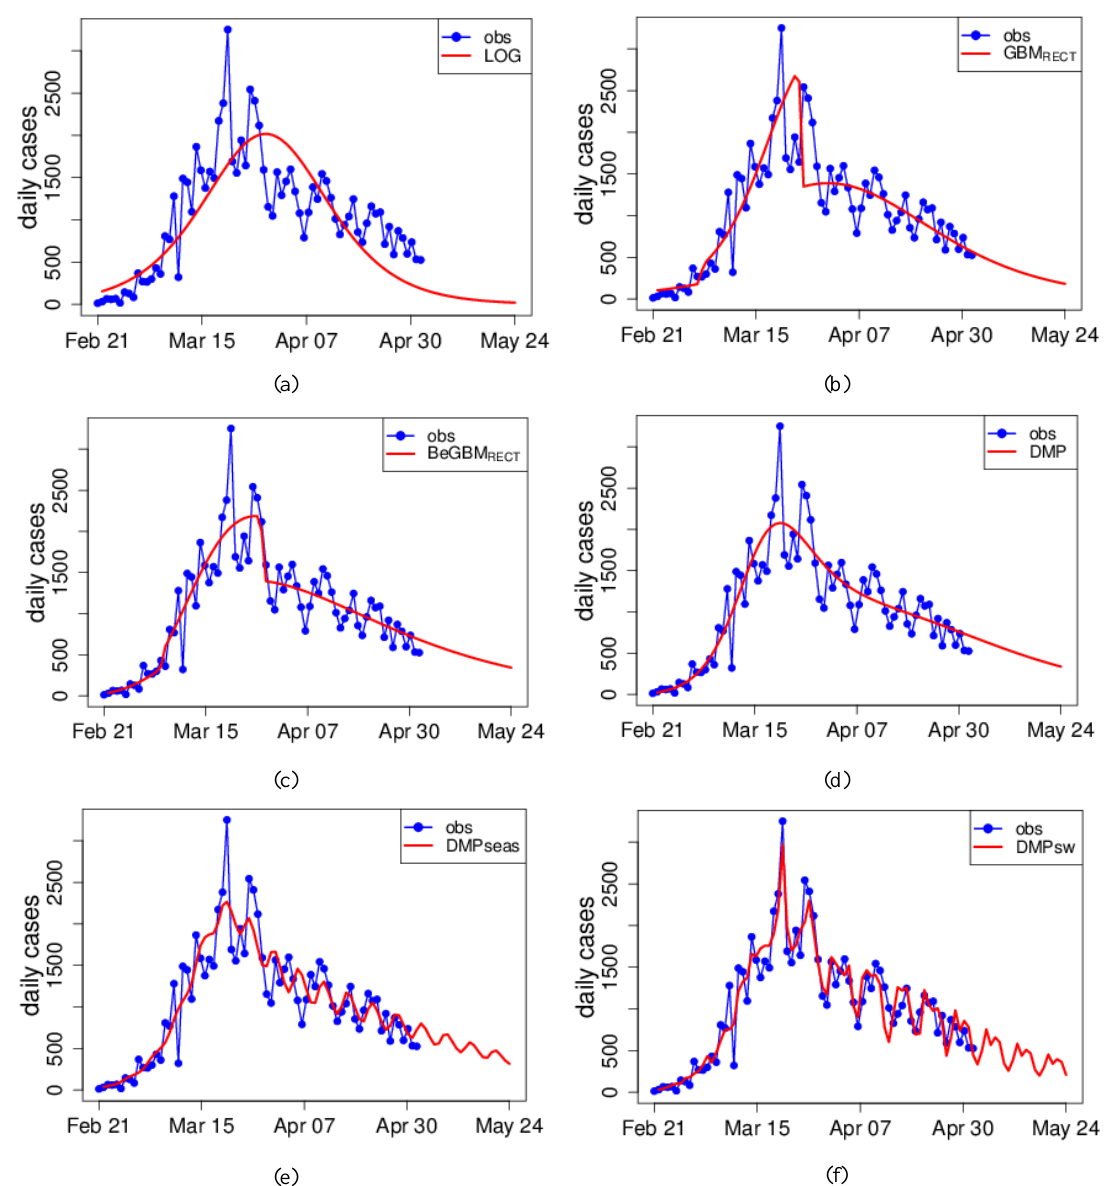
Figure 6. Lombardy. Observed and fitted values with the alternative models. (a) Logistic (LOG); (b) GBM with rectangular shock (GBM 𝑹𝑬𝑪𝑻 ); (c) Bemmaor GBM with rectangular shock (BeGBM 𝑹𝑬𝑪𝑻 ); (d) Dynamic market potential (DMP); (e) Dynamic market potential+seasonal effect (DMPseas); (f) Dynamic market potential+swabs